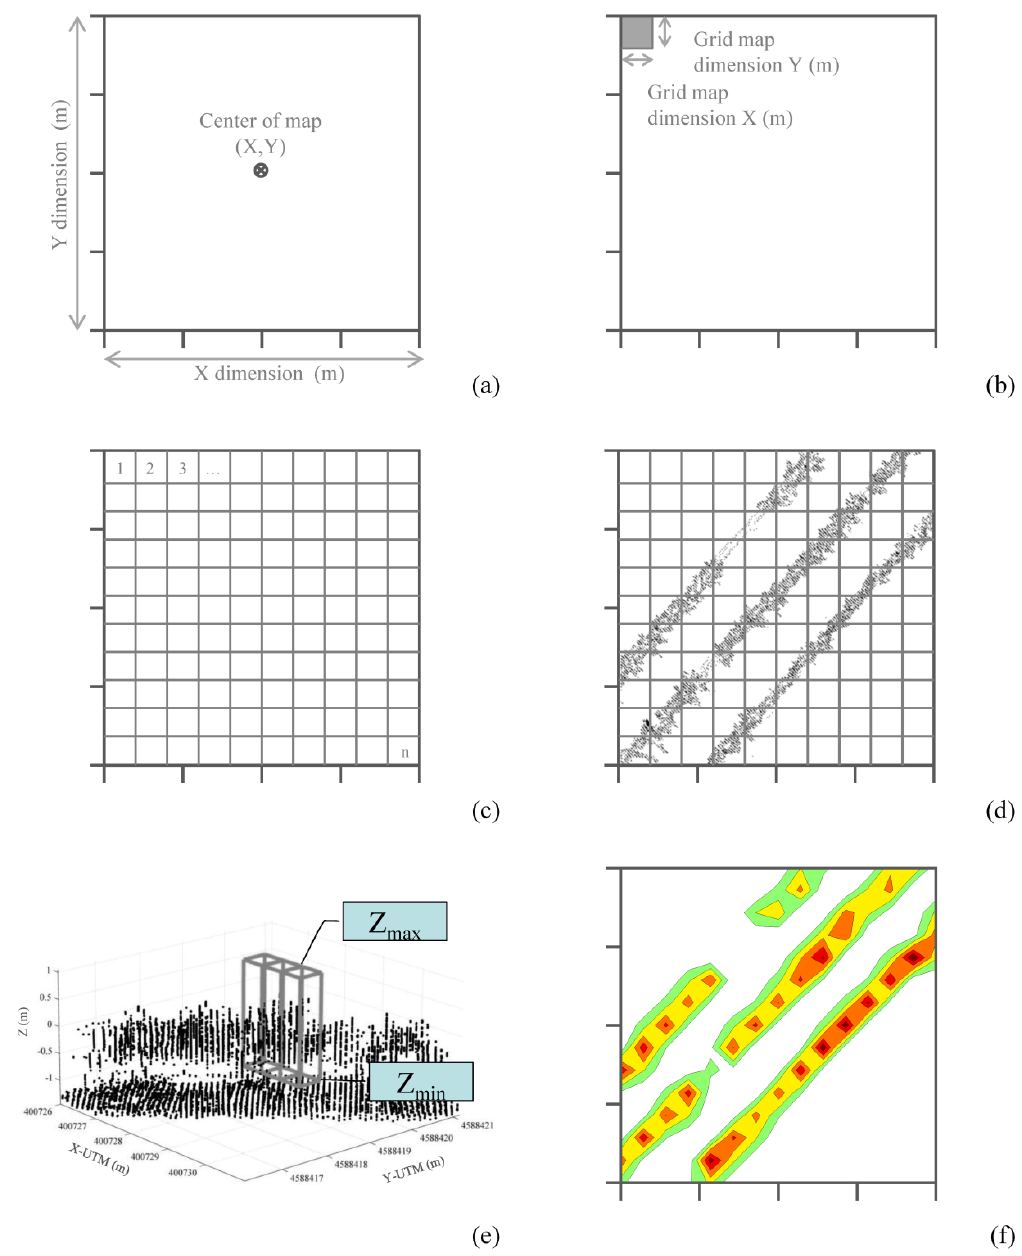
area characteristics; (b) grid definition; (c) mapped area divided according to the defined grid; (d) defined grid area with all measured points; (e) assignment of minimum and maximum height in each cell of the grid; (f) plot of map of density according to the established